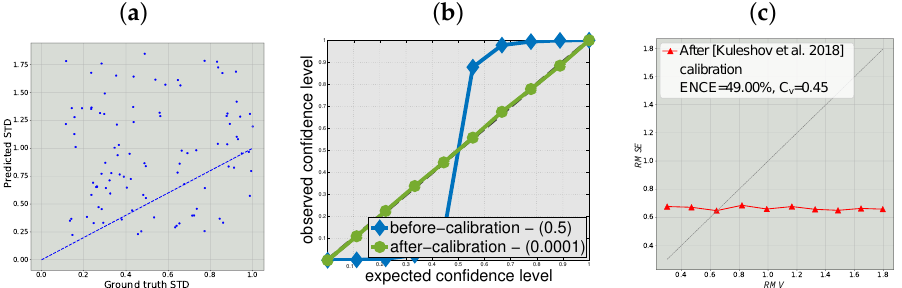
Figure 1. Results for the synthetic regression problem with random uncertainty estimation: ( a ) real vs. predicted STDs after confidence interval calibration [1]; ( b ) confidence intervals method evaluation of calibrated random uncertainty; and ( c ) reliability diagram using our evaluation method after [1] calibration. Grey dashed line indicates the ideal calibration.